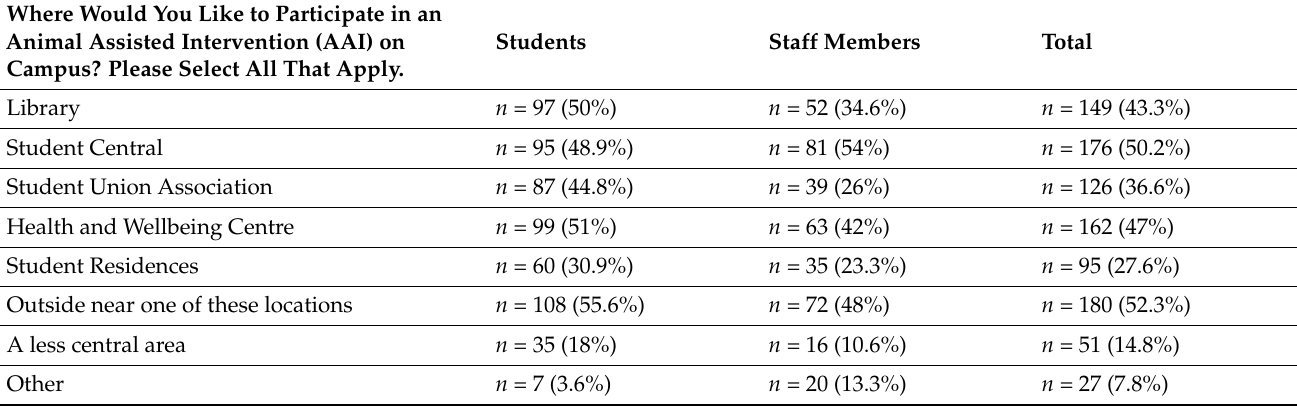
Table 2. location survey